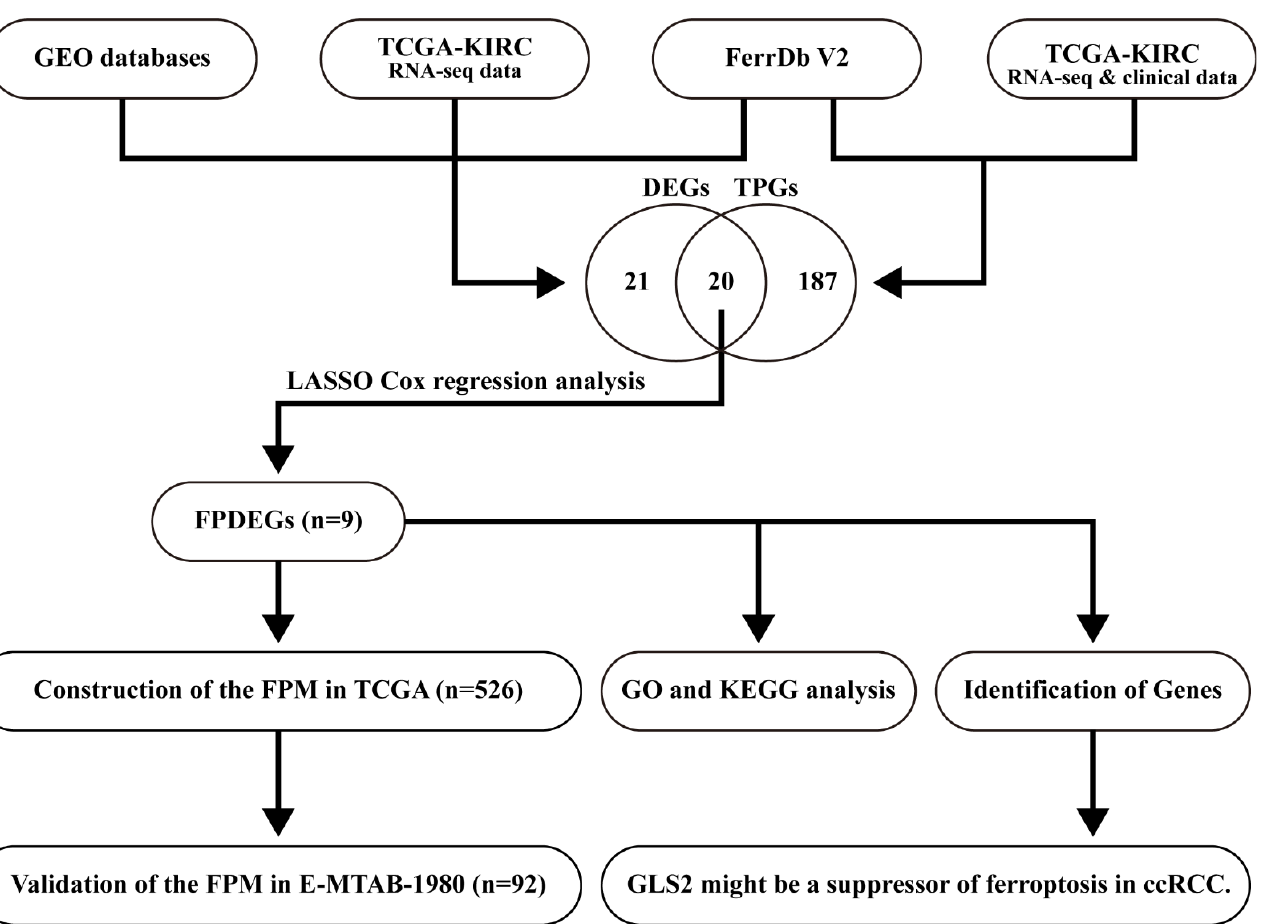
Figure 1. Flow chart of identification and validation.